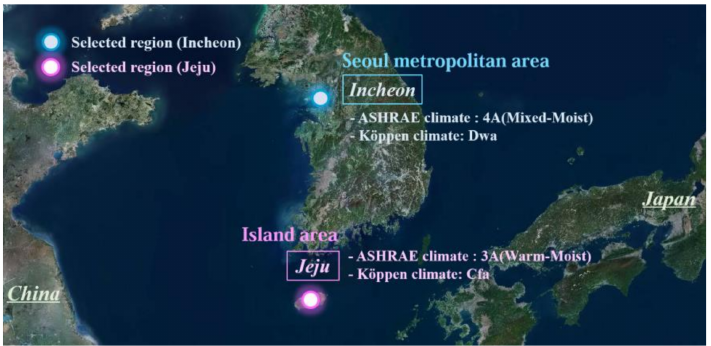
Figure 4. The two selected regions (Incheon and Jeju).